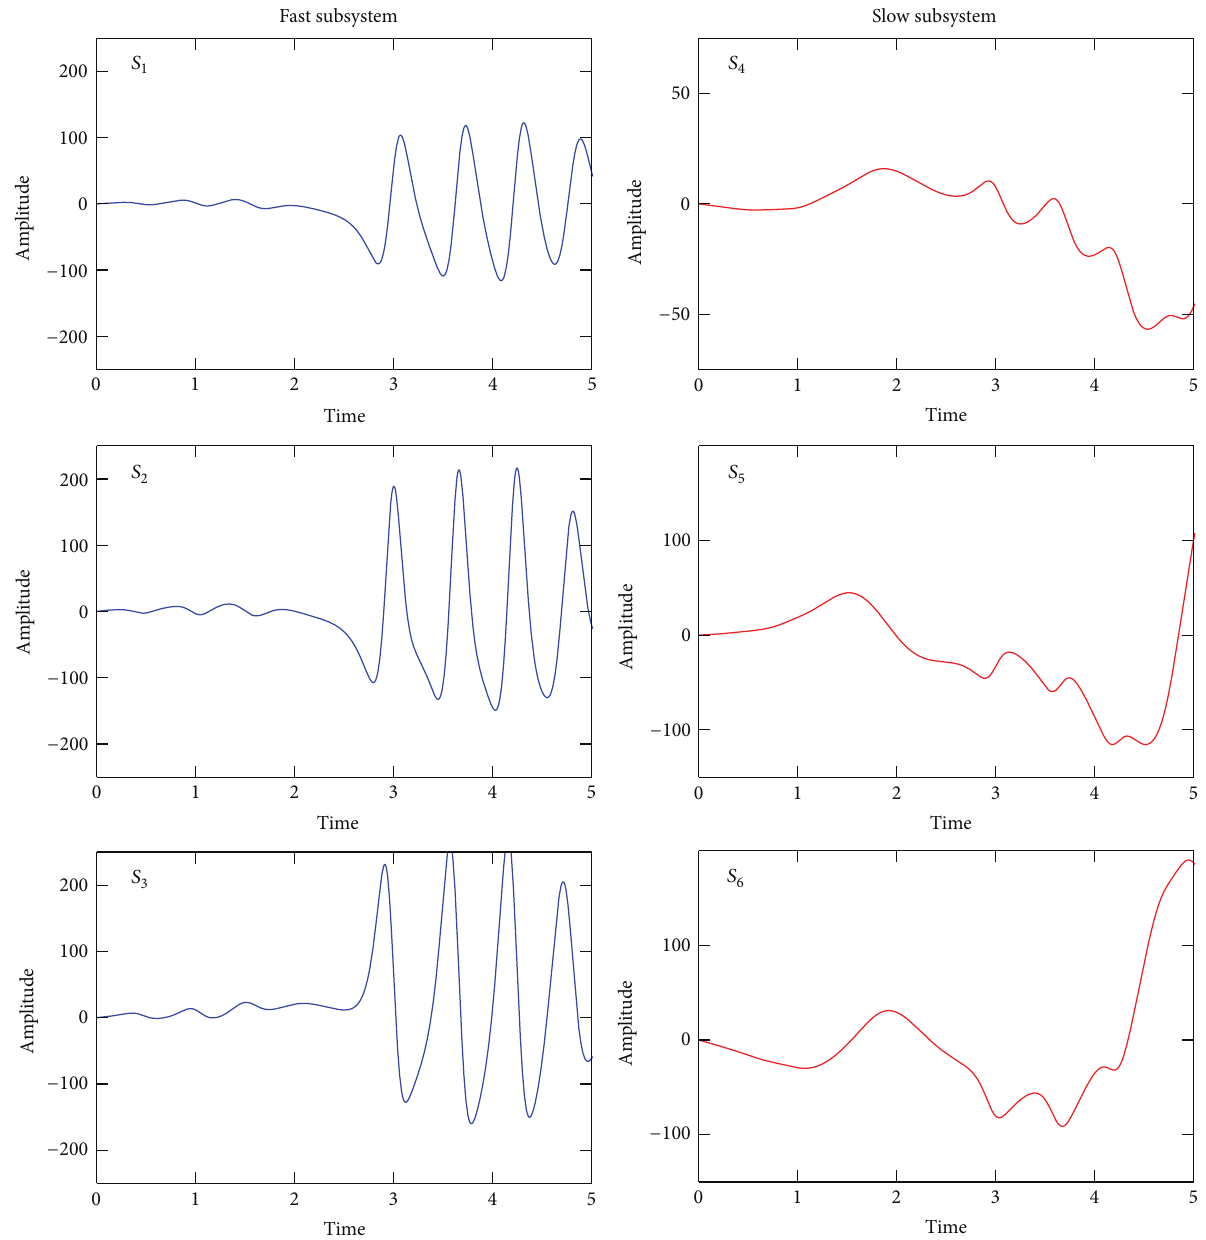
Figure 5: Time dynamics of sensitivity functions with respect to parameter 𝑐 on the time interval [0, 5] for 𝑐 0 = 0.9 .